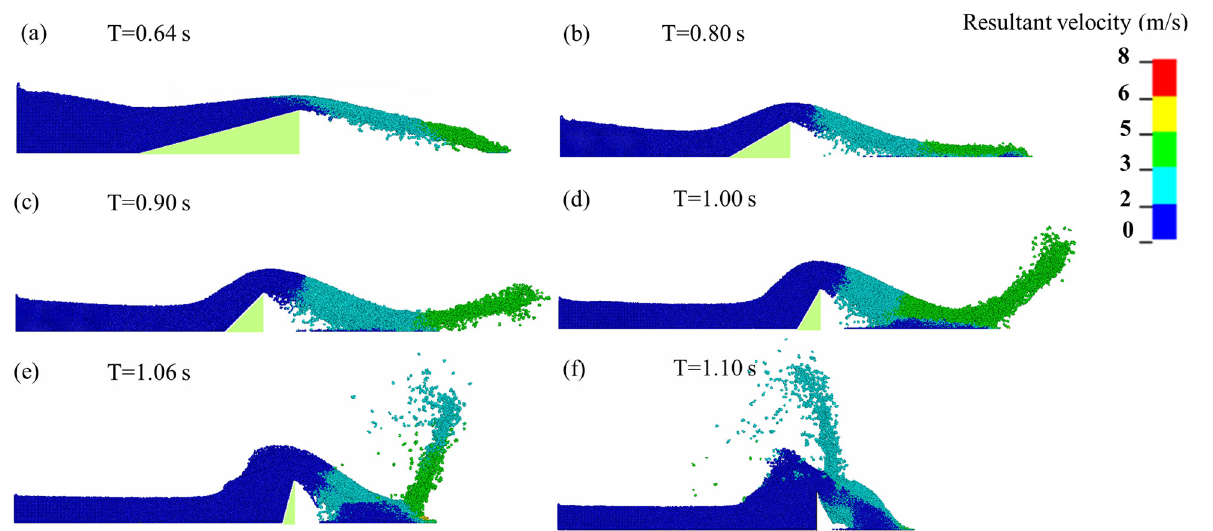
Figure 9. Tailings flow forms corresponding to the moment of K 2 appearing: ( a ) 15°; ( b ) 30°; ( c ) 45°; ( d ) 60°; ( e ) 75°; ( f ) 90°.